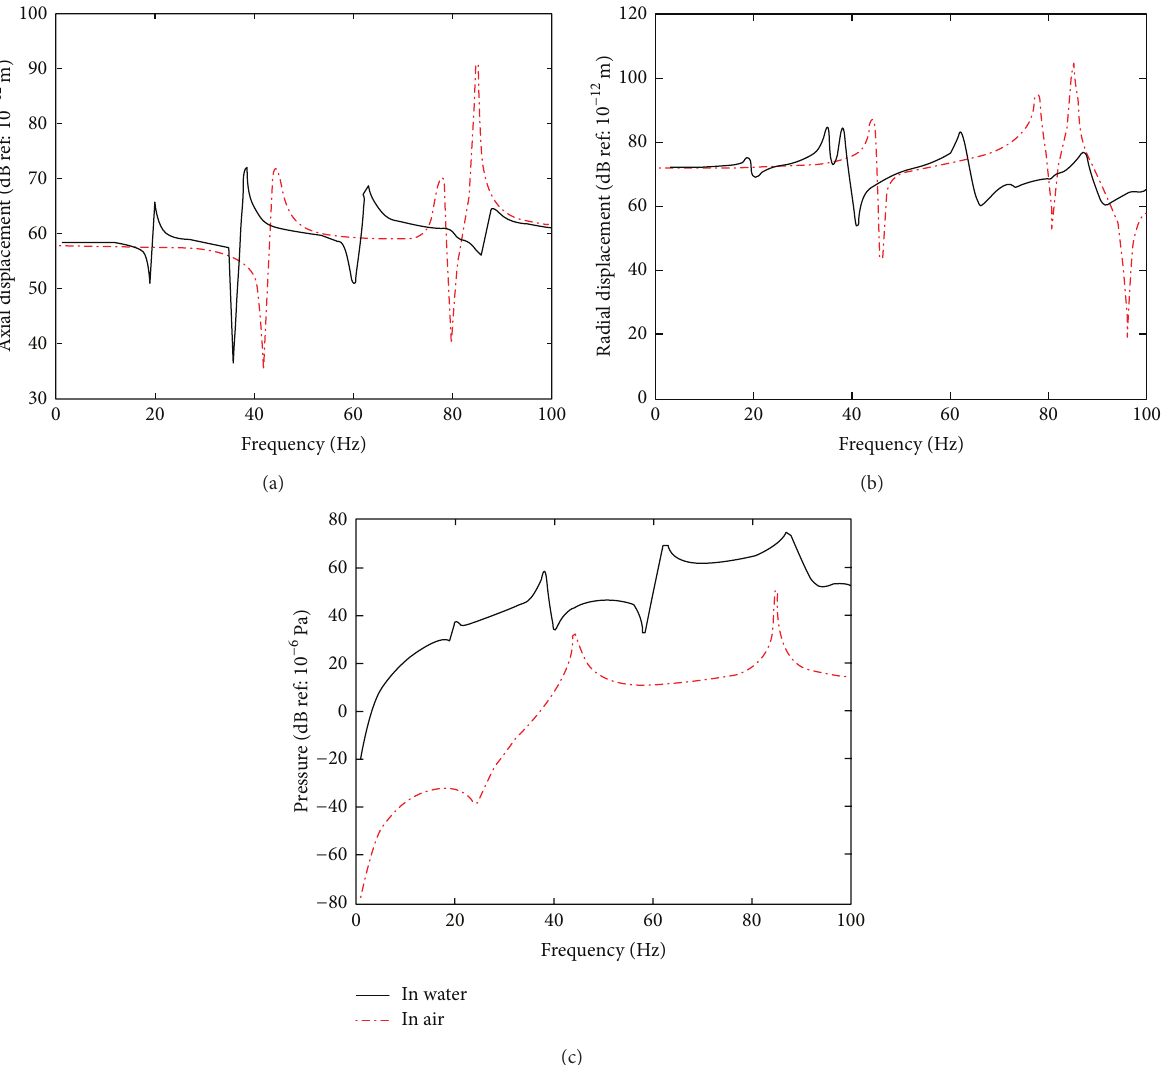
Figure 11: Comparison of conical shells in water and in air, under 𝐹 1 (a) axial displacement, (b) radial displacement, and (c) far-field